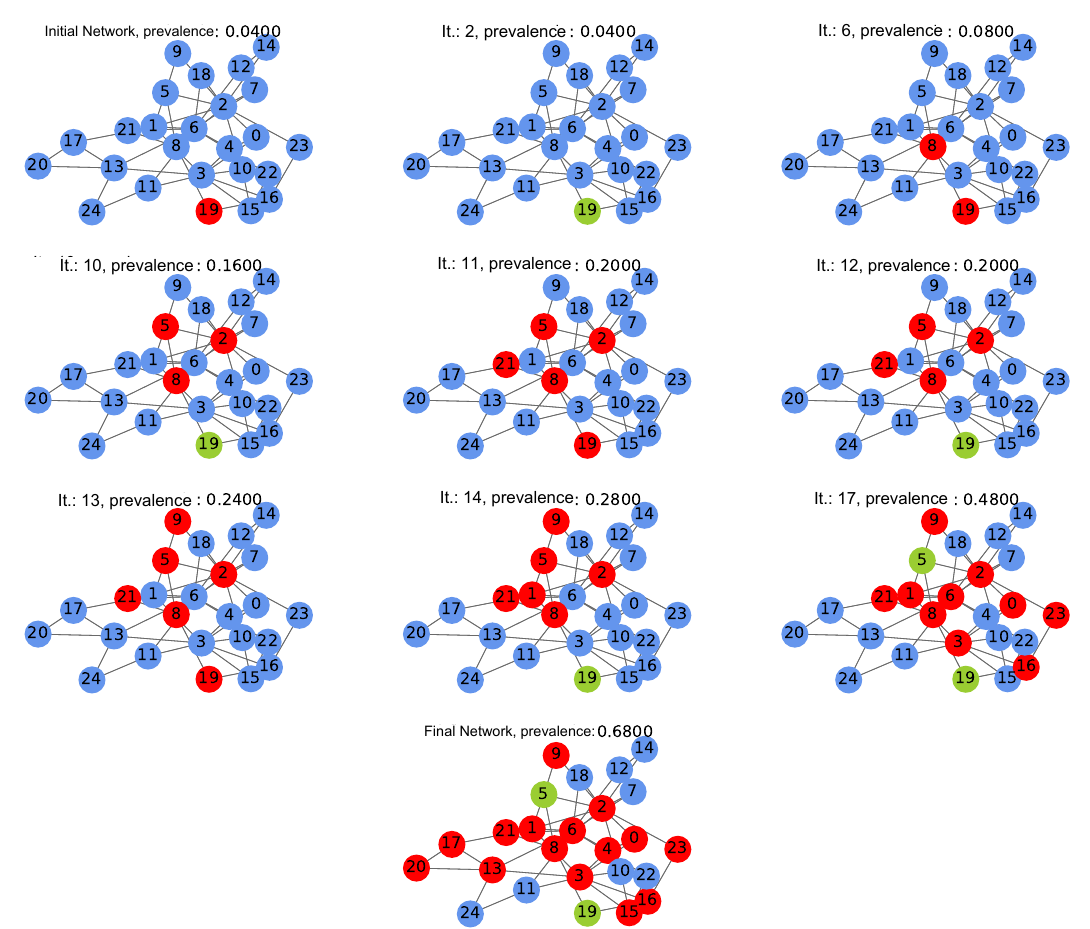
Figure 7. Schematic representation of the network showing the evolution with respect to time for N T = 25, τ = 20, γ = 3.4, and k = 2. The blue vertices represent people susceptible of acquiring the infection; those in red, carriers without ART; those in green, the carriers who use ART. The scenario displayed does not seek to represent reality, it only aims to illustrate the operation of the coupled model.